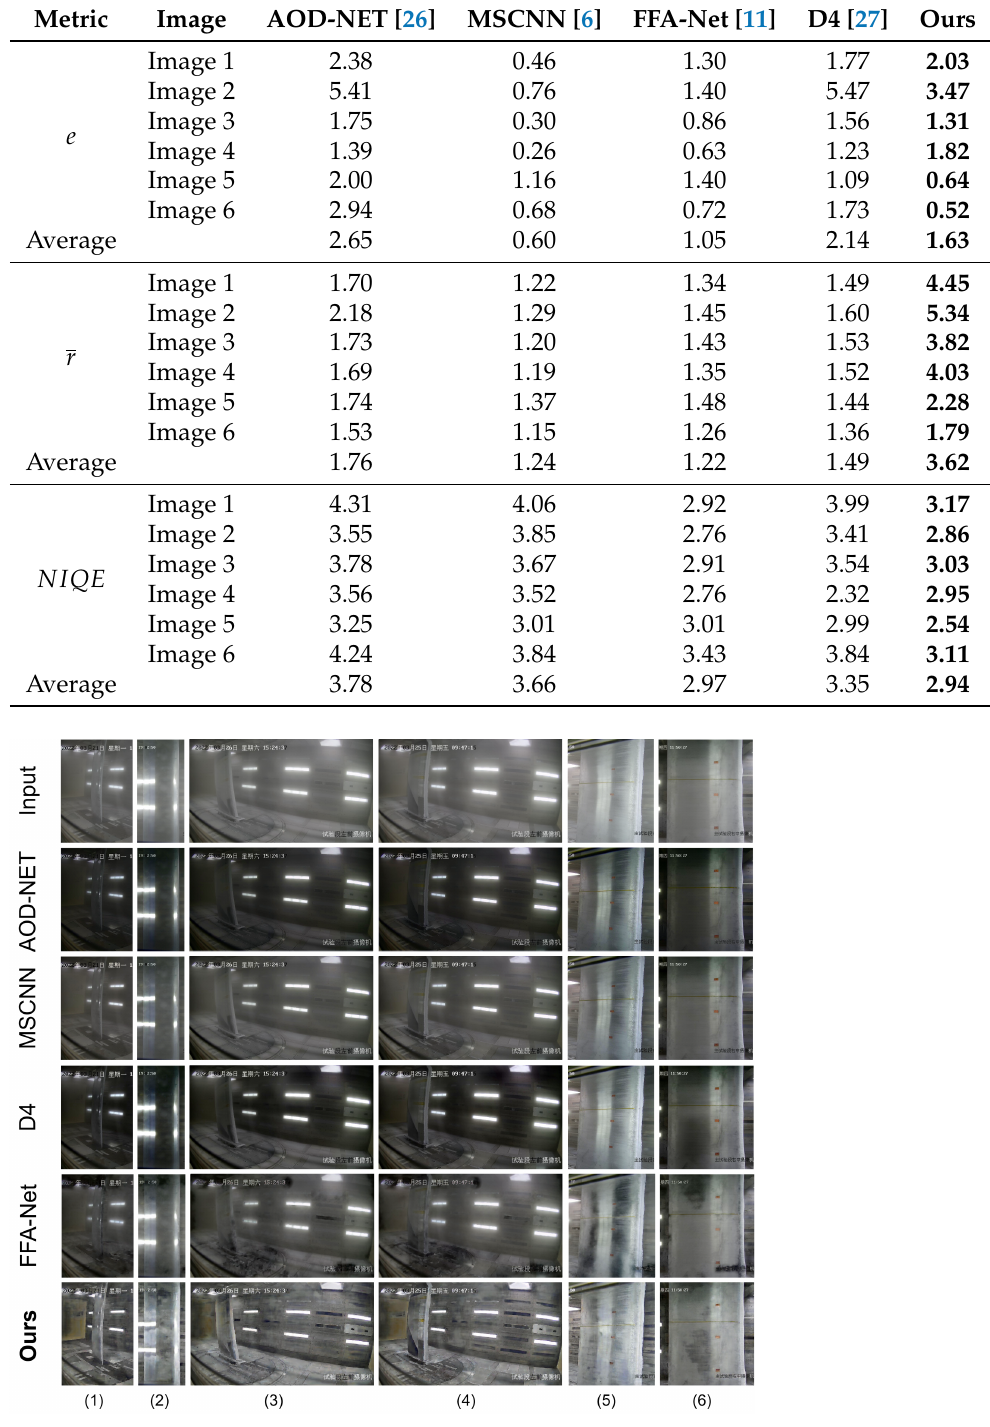
Table 3. Comparison of results of deep learning methods on the test set.